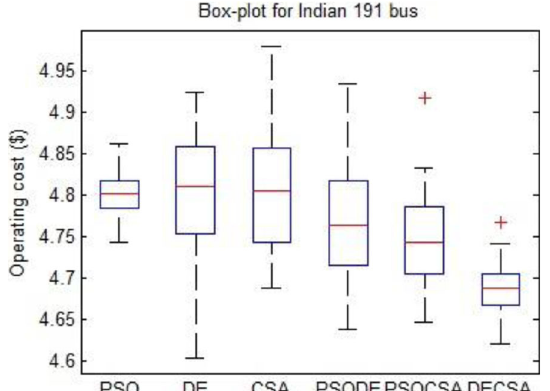
Fig. 13 Box plot for the System 2